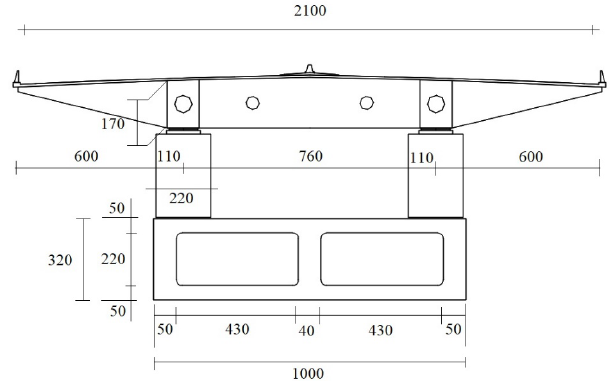
Figure 2. Cross section of the composite deck and RC arch at the P6 position. All measurements are in cm.